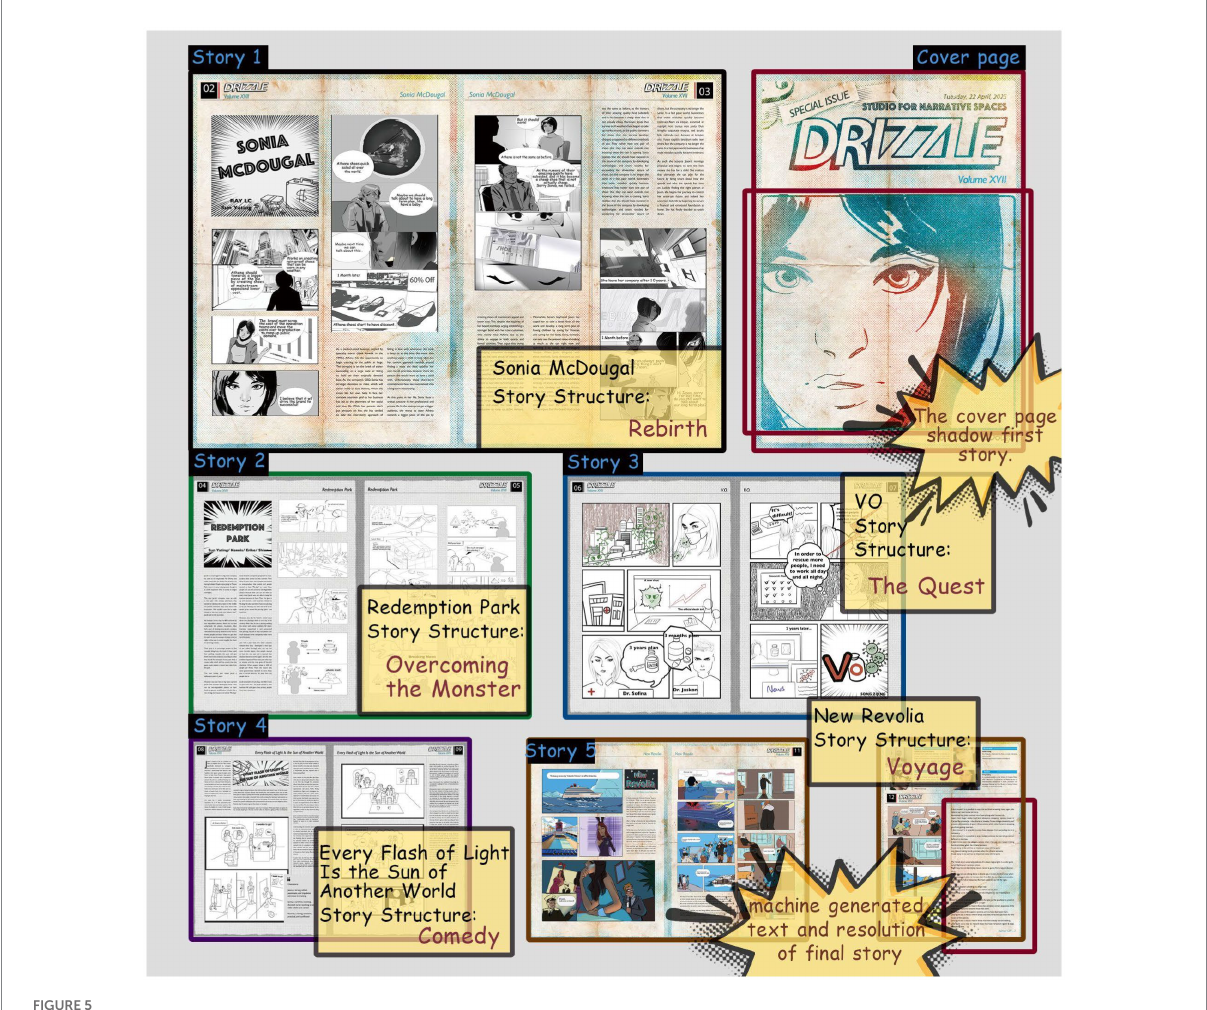
FIGURE 5 Layout of Drizzle and design purpose for each